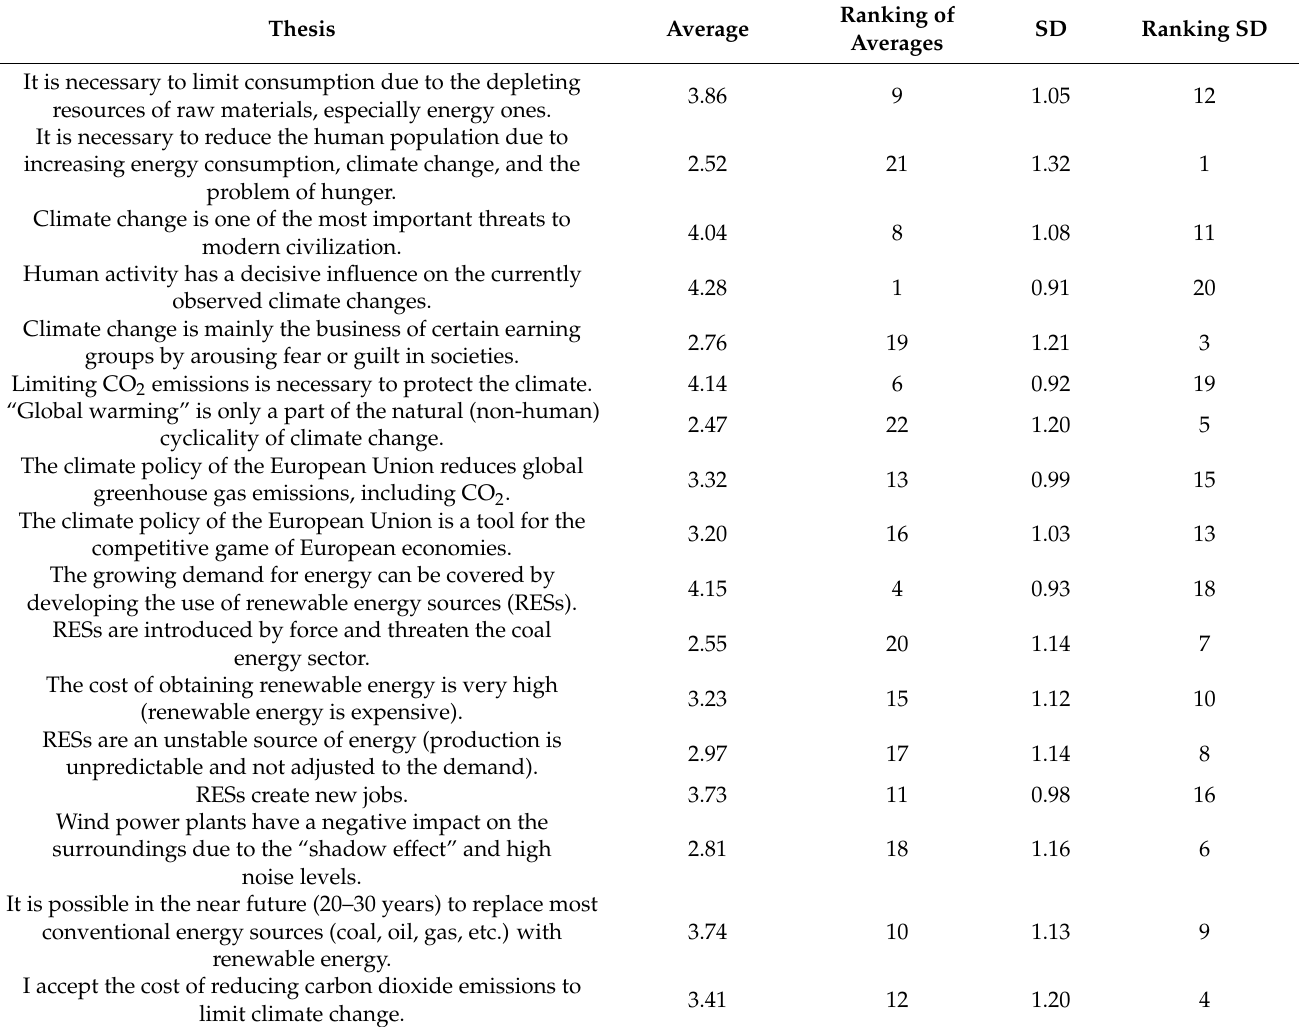
Table 3. Average scores for theses diagnosing the perception of the analyzed issues, standard deviations (SD), and rankings of these measures. Thesis Average